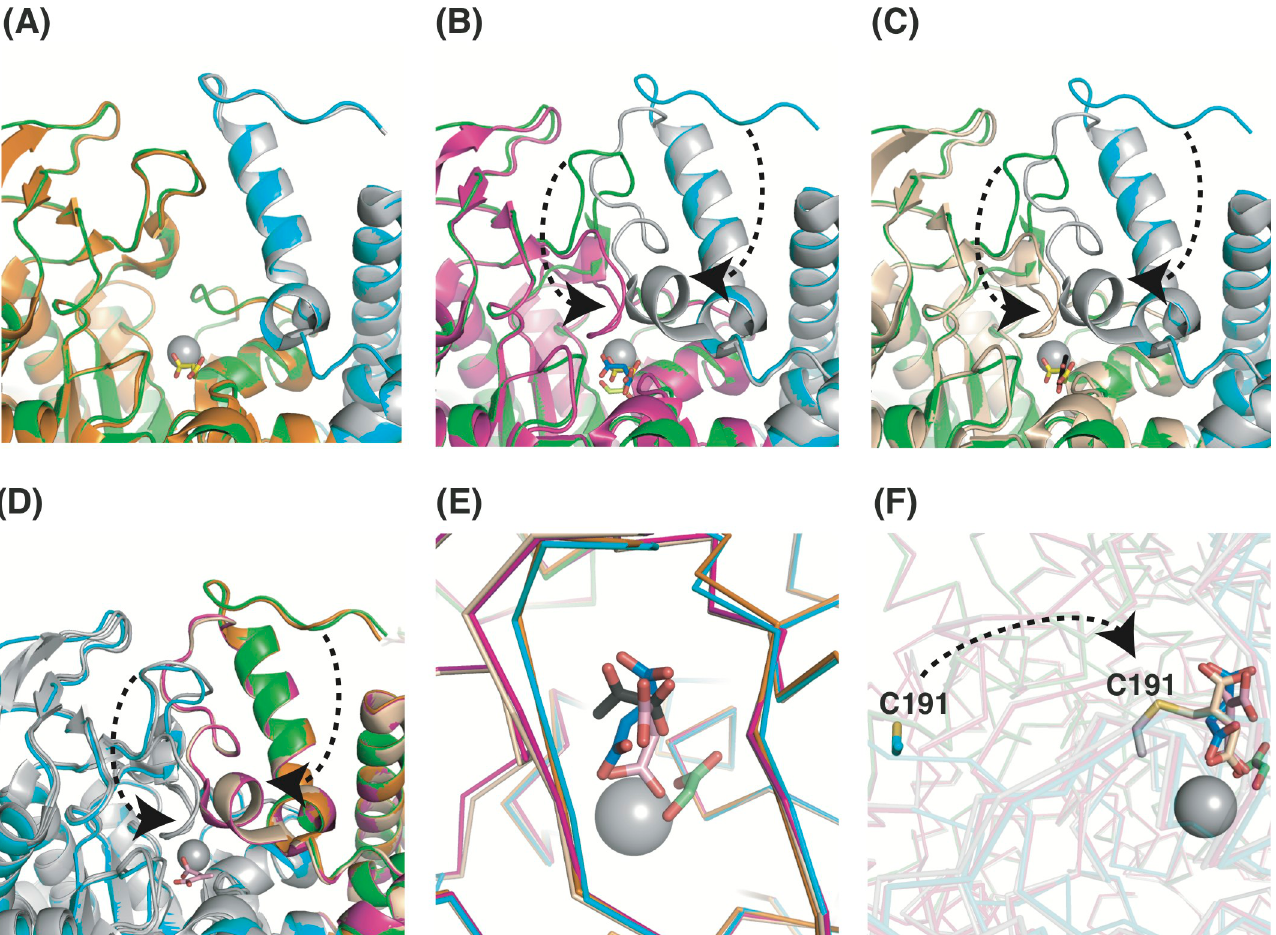
Fig 3. Structural comparison with other conformers. Structural comparison of the L5 loop and the C-terminal tail. Subunit A of our tbICL structure (green) is superimposed onto those of the native form (A; orange), glyoxylate and succinate complex (B; magenta), and pyruvate complex (C; wheat) structures. Subunits B are colored gray except for our structure (cyan). All views are restricted to the active site. Succinate from our structure (yellow), glyoxylate (limon), succinate (blue; PDB code: 1F8I), pyruvate (black), and Mg 2+ ions (gray) are represented by sticks and spheres. The curved arrows indicate conformational changes of the L5 loop and the C-terminal tail. (D) Subunit B of our tbICL structure (cyan) is superimposed onto those of the structures shown in panel (C). Subunit B, except for our structure, is colored gray for clarity. The pink stick represents itaconate. (E) Magnified view of the active site. Stick symbols and color codes are the same as in panels (A)–(D). (F) Magnified view of the active site in subunit B of our structure, the succinate/glyoxylate-complex structure, and another itaconate (wheat) complex structure (PDB code: 6XPP). Stick symbols and color codes are the same as in panels